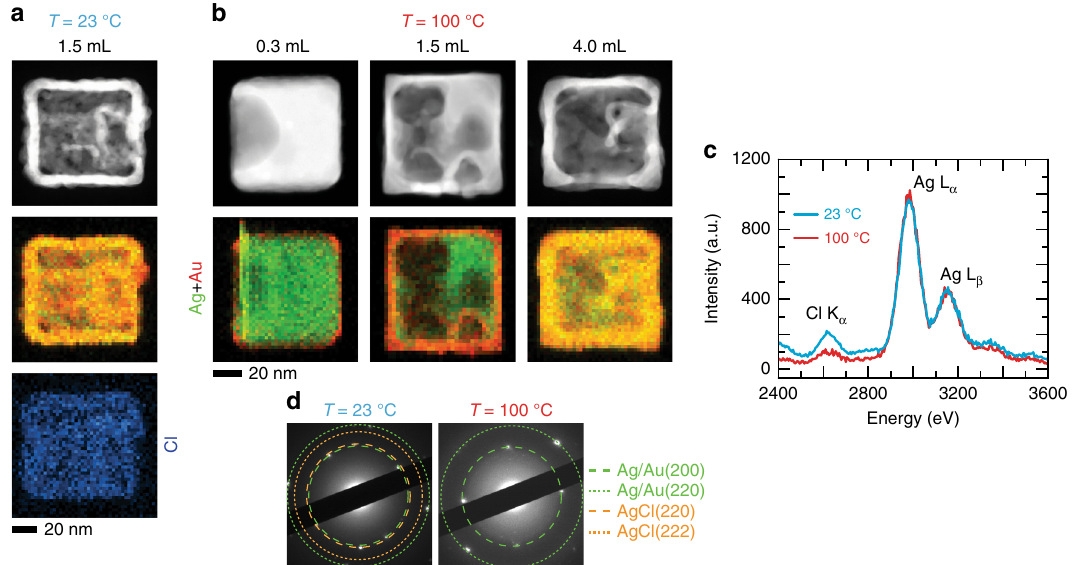
Fig. 2 Chemical and structural characterization of Ag/Au nanostructures synthesized ex situ. a Scanning TEM annular dark fi eld image and corresponding energy dispersive X-ray spectroscopy (EDX) chemical maps of nanostructures synthesized ex situ at 23 °C. b Nanostructures synthesized at 100 °C after adding 0.3, 1.5, and 4.0 mL of 0.1 mM HAuCl 4 . c EDX spectra for samples synthesized at 23 and 100 °C (with 1.5 mL of 0.1 mM HAuCl 4 added) showing the Cl K and Ag L lines. d Selected area electron diffraction from a single nanostructure in both samples (with 1.5 mL of 0.1 mM HAuCl 4 added), where diffraction spots for AgCl 44 are frequently found in the 23 °C sample because of lower solubility of AgCl at 23 °C than at 100